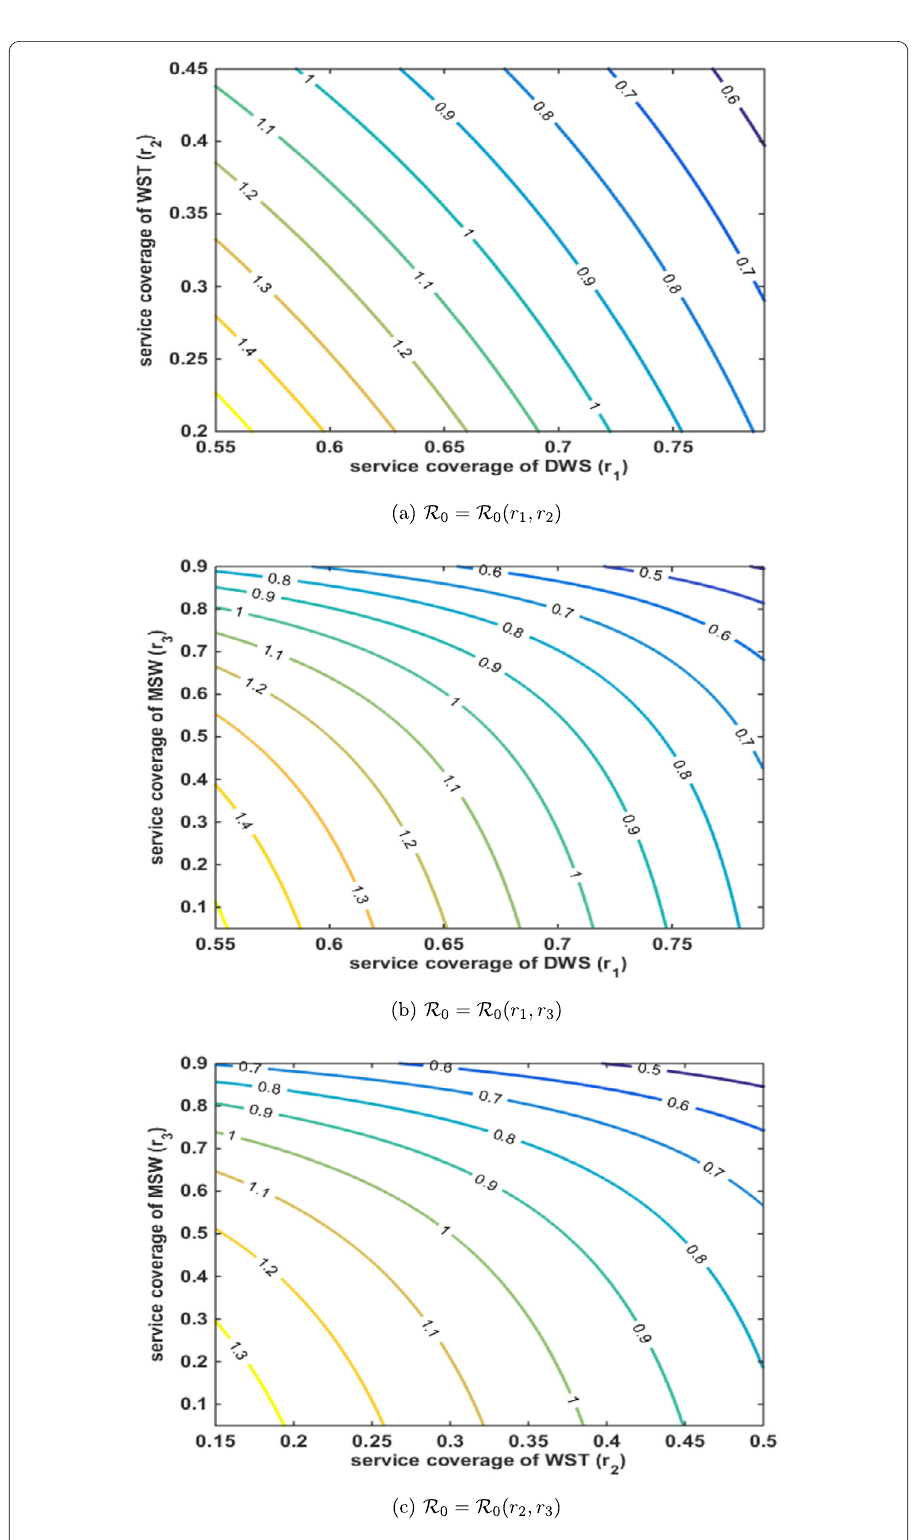
Figure 3 Contour plots of the surface R 0 as the function of the services coverage r 1 , r 2 , and r 3 . The values of the other model parameters are given in Table